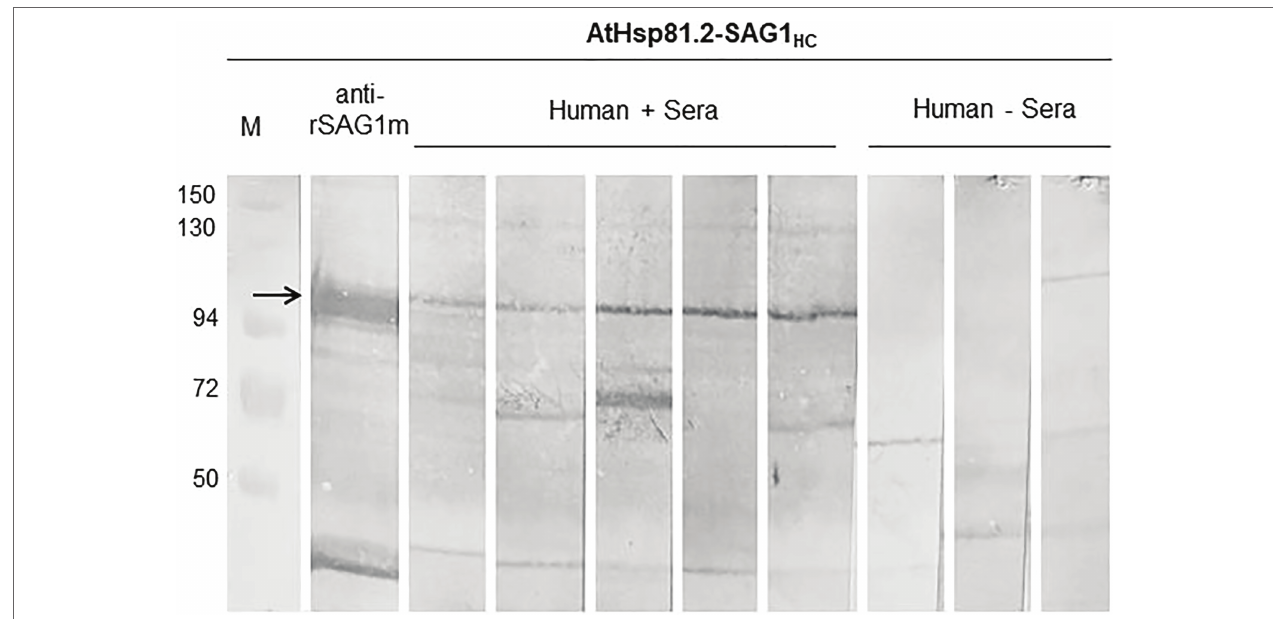
FIGURE 8 | The reactivity of plant-expressed AtHsp81.2-SAG1 HC . All seropositive samples reacted with a specific band that correspond to the expected size of AtHsp81.2–SAG1 HC (110 kDa), and it is indicated with arrow. Seronegative human serum samples did not react with any bands of approximately 110 kDa. In IgG, the immunoblot assays, leaf extract samples were separated using 10% sodium dodecyl sulfate-polyacrylamide gel electrophoresis (SDS-PAGE) under reducing conditions. Immunoblot profiles of AtHsp81.2–SAG1 HC leaf extracts were probed with human negative sera (1:100), human Toxoplasma -positive sera (1:100), and mouse anti-rEcSAG1 m polyclonal antibody